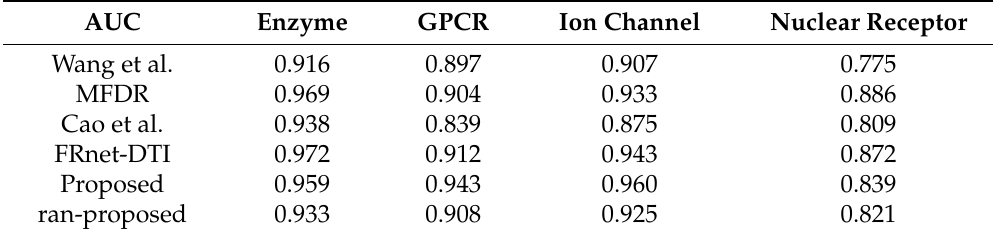
Table 4. Comparison with state-of-the-art methods on the gold standard dataset. Proposed and ran-proposed represent the predictions with proposed work and random sampling,